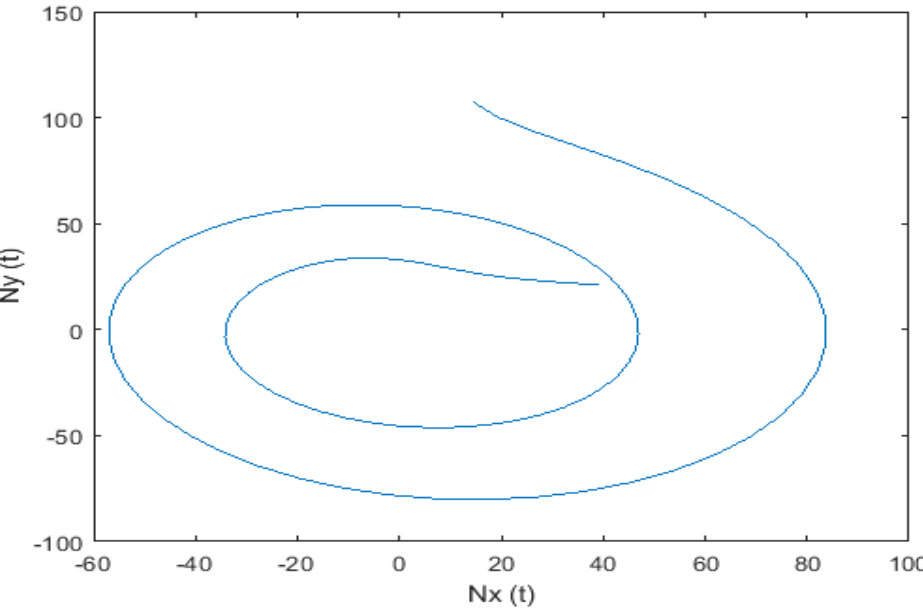
Figure 10. Numerical solutions of the Bloch equation in the plane (𝑁 (cid:3051) vs. 𝑁 (cid:3052) ) with parameters: 𝛼 = 1.0, 𝛽 = 0.9,𝛾 = 0.8 , 𝑤 (cid:2868) = 12 , 𝑇 (cid:2869) = 1 , 𝑇 (cid:2870) = 20, 𝑎 = 1, 𝑏 = 1 .